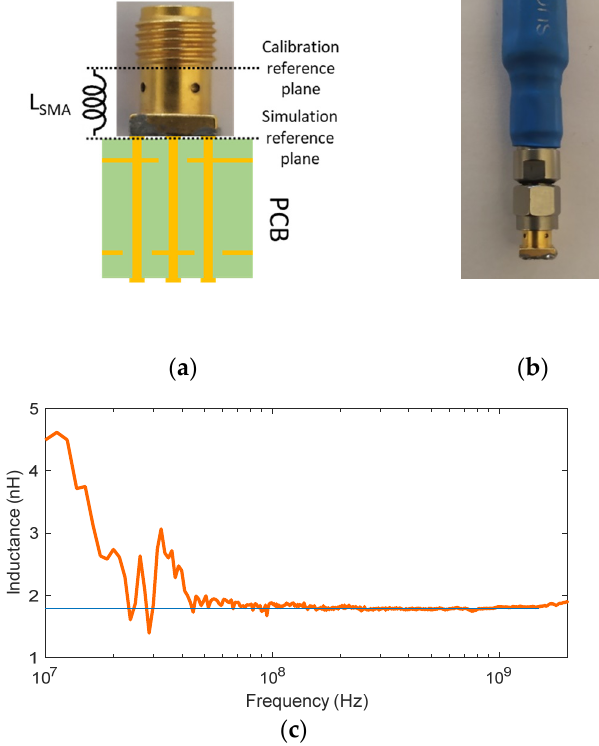
Figure 9. ( a ) Identification of the L SMA additional inductance; ( b ) measurement setup to extract L SMA ; ( c ) measured L SMA .